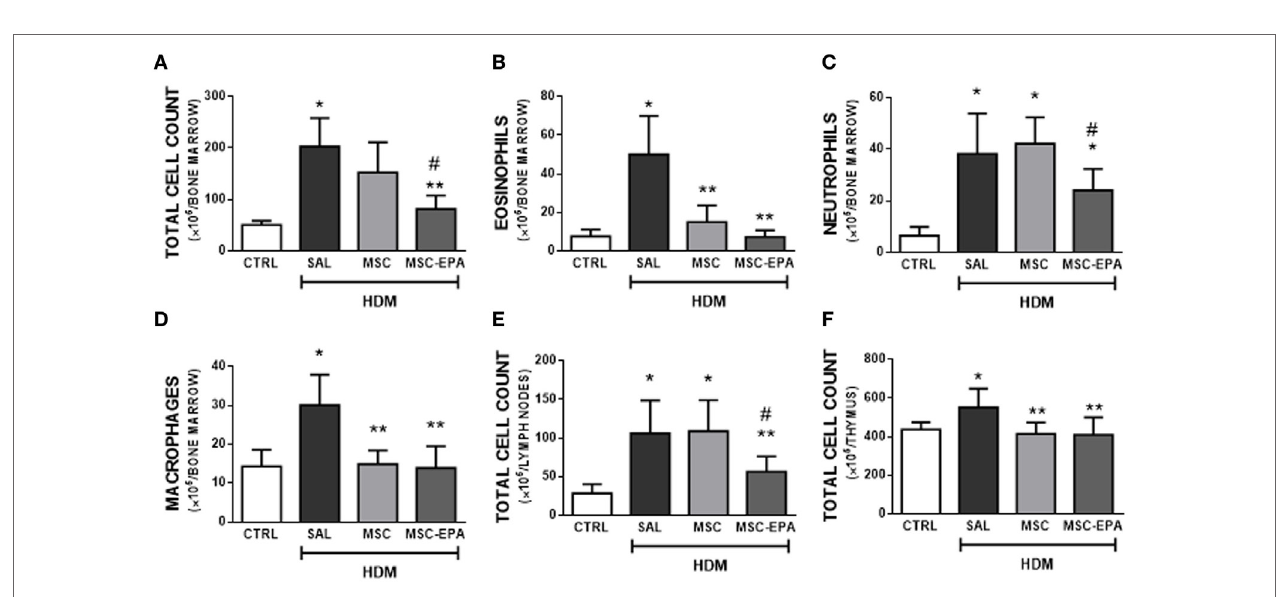
FigUre 4 | EPA-stimulated MSCs led to greater reductions in bone marrow, lymph nodes, and thymus cellularity than unstimulated MSCs. (a) Total leukocytes, (B) eosinophils, (c) neutrophils, (D) macrophages in bone marrow, (e) total leukocytes in mediastinal lymph nodes, and (F) total leukocytes in thymus. CTRL, saline-challenged mice; HDM, HDM-challenged mice; SAL, HDM mice treated with saline; MSC, HDM mice treated with unstimulated MSCs; MSC-EPA, HDM mice treated with EPA-stimulated MSCs. One-way ANOVA followed by Tukey’s test was used for statistical comparison. Data are presented as mean + SD. n = 8 animals/group. *Significantly different from CTRL ( p < 0.05). **Significantly different from HDM-SAL ( p < 0.05). # Significantly different from HDM-MSC ( p < 0.05). Abbreviations: EPA, eicosapentaenoic acid; MSCs, mesenchymal stromal cells; HDM, house dust mite.